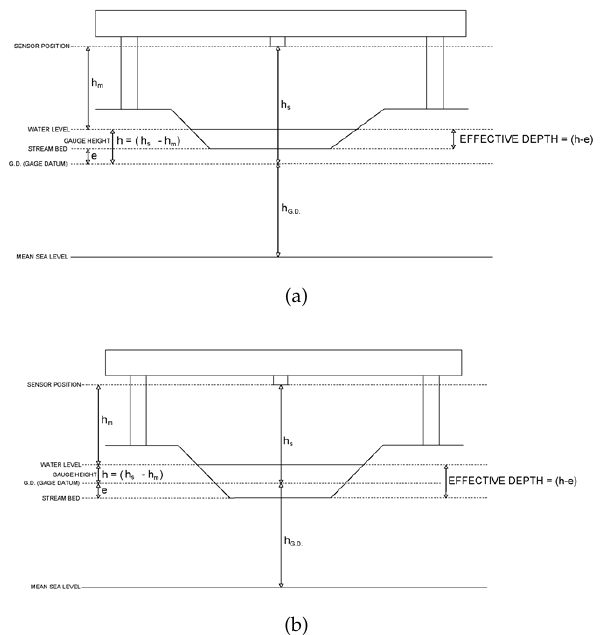
Figure 3. Gauge sensor applied under bridge to measure river stage and depth. ( a ) In this case, G.D. < stream bed. ( b ) In this case, G.D. > stream